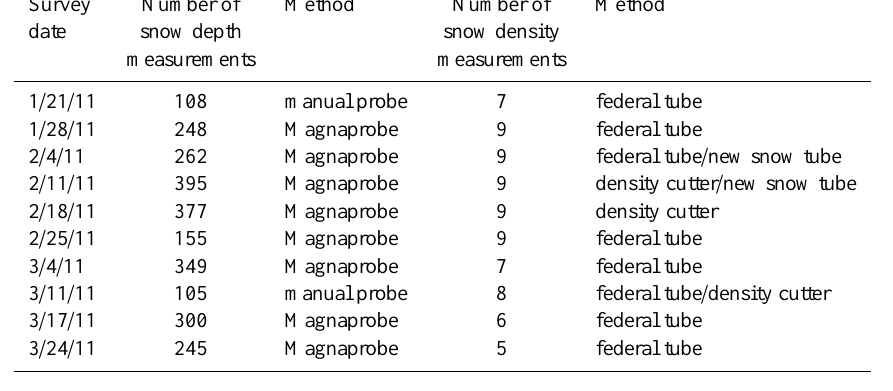
Table 4. Summary of snow survey data including the date, and number and method of snow depth and density measurements.